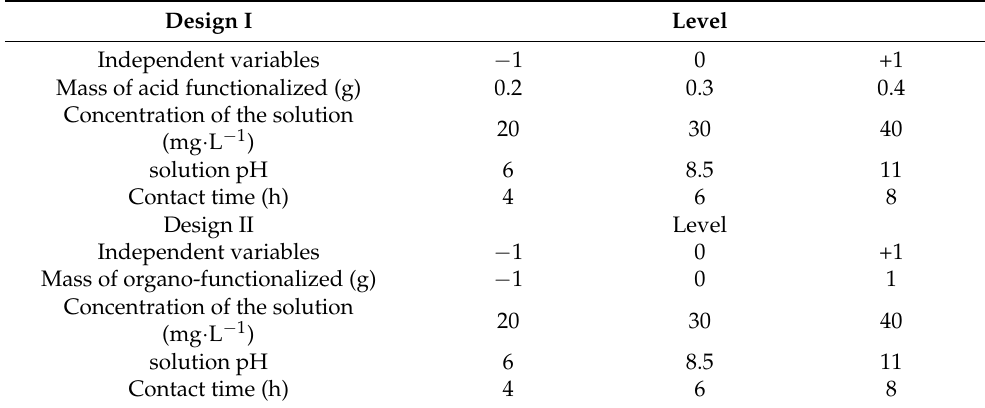
Table 1. Decoded and real values of the variables independent of the experimental design in the adsorption of sodium